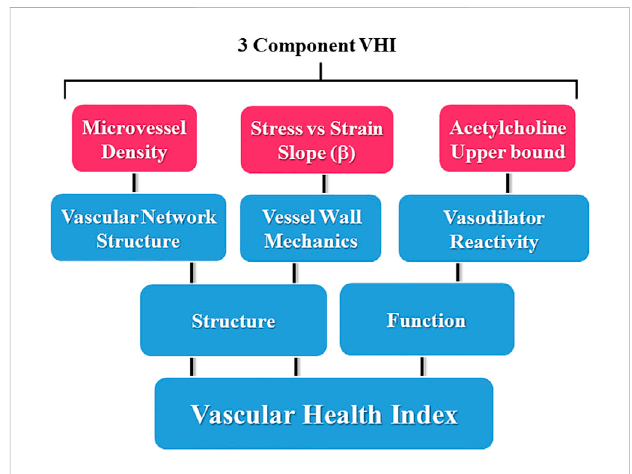
Schematic representation of the components contributing to the three-parameter calculations for the Vascular Health Index (VHI), and their context within the scope of vascular structure and function. Please see text for